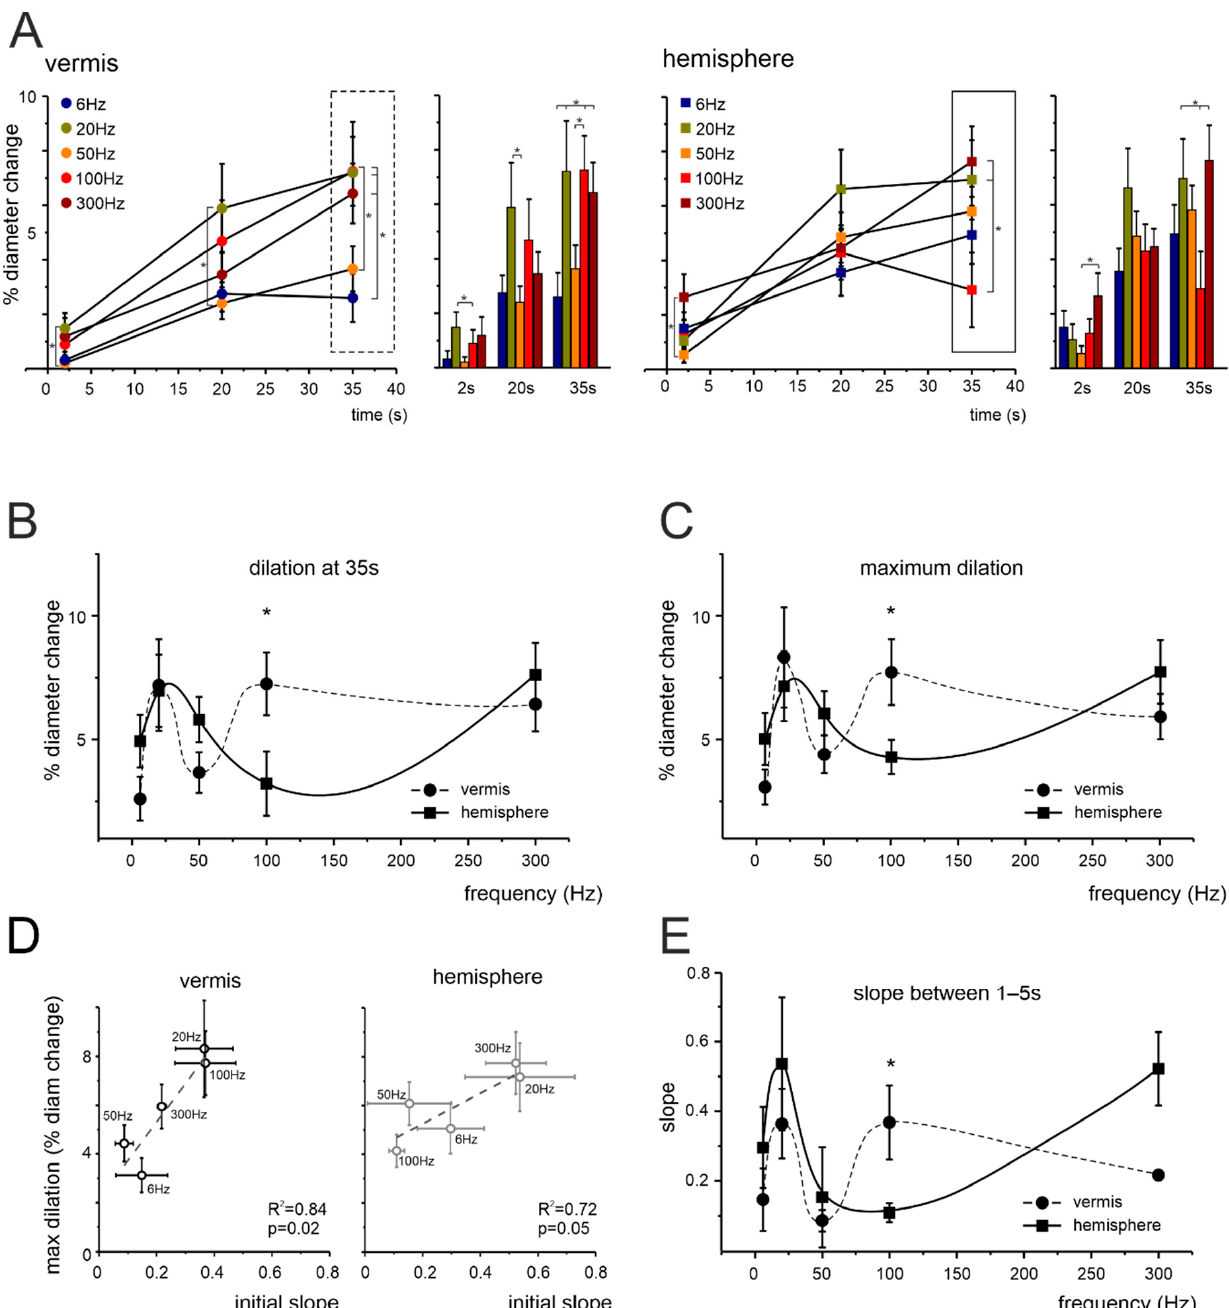
Figure 2. NVC frequency dependence in the cerebellar granular layer. ( A ) Average time course of vasodilation during mossy fibers stimulation at 2, 20, and 35 s in capillaries of the vermis and hemisphere. Asterisks indicate pairs of points that were statistically different (* p < 0.05). Vermis: 2 s, 20 Hz vs. 50 Hz ( p = 0.039); 20 s, 20 Hz vs. 50 Hz ( p = 0.0358); 35 s, 6 Hz vs. 100 Hz ( p = 0.014), 50 Hz vs. 100 Hz ( p = 0.049), 6 Hz vs. 20 Hz ( p = 0.015), 6 Hz vs. 300 Hz ( p = 0.036) (one-way ANOVA; for increasing frequencies n = 9, 10, 10, 10, 11, respectively). Hemisphere: 2 s, 50 Hz vs. 300 Hz ( p = 0.029); 35 s, 100 Hz vs. 20 Hz ( p = 0.024), 100 Hz vs. 300 Hz ( p = 0.009) (one-way ANOVA; for in- creasing frequencies n = 9, 10, 10, 10, 10, respectively). The box markers show the data that are used for plots in ( B ), unfolded along the x -axis. ( B ) Average dilations at 35 s at each frequency tested in the vermis and hemisphere (dots and squares, respectively, connected by trend lines). The dilations in the vermis and hemisphere were statistically different at 100 Hz ( p = 0.039). ( C ) Same plot as in ( B ), using the maximum dilation instead of the dilation at a fixed time point. The dilations in the vermis and hemisphere were statistically different at 100 Hz ( p = 0.022). ( D ) The plots show the positive correlation between the maximum dilation at each frequency and the slope in the first 1–5 s, for the vermis (left) and hemisphere (right). ( E ) Same plot as in ( B , C ), using the slope in the first